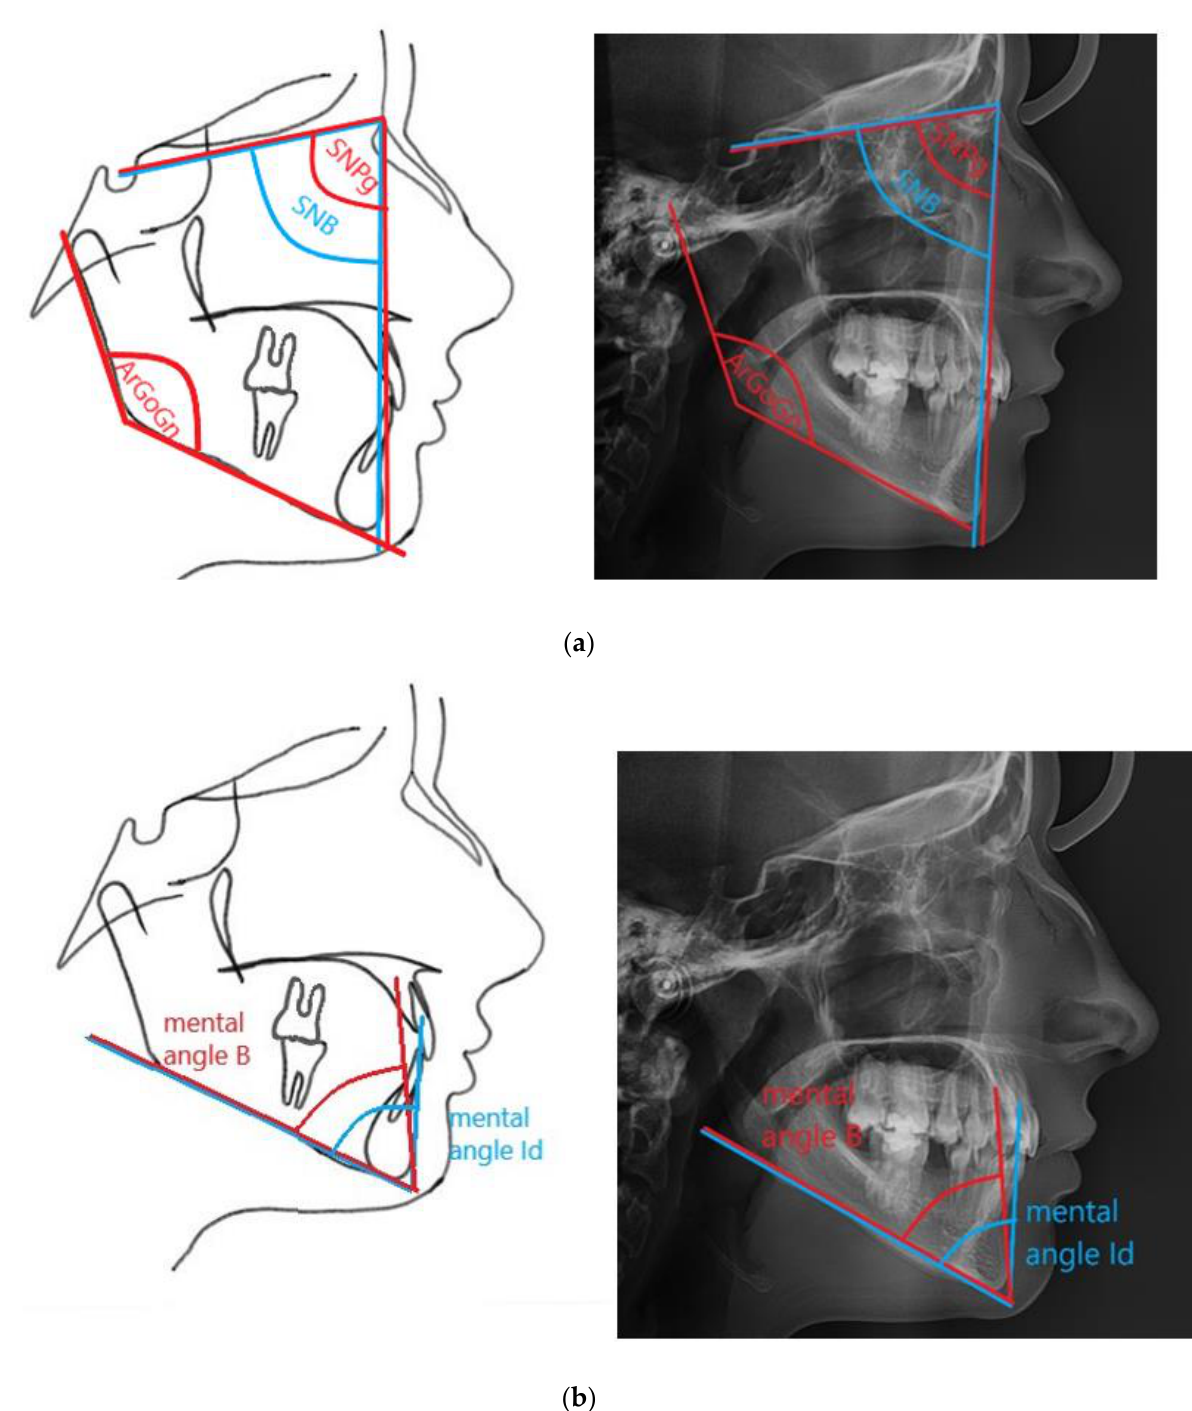
Figure 1. Angular measurements of the mandible used in the study. ( a )shows mandibular angle and anteroposterior position of the mandible and the chin; ( b ) shows anteroposterior position of the B point and Id point, relative to the Pg point.